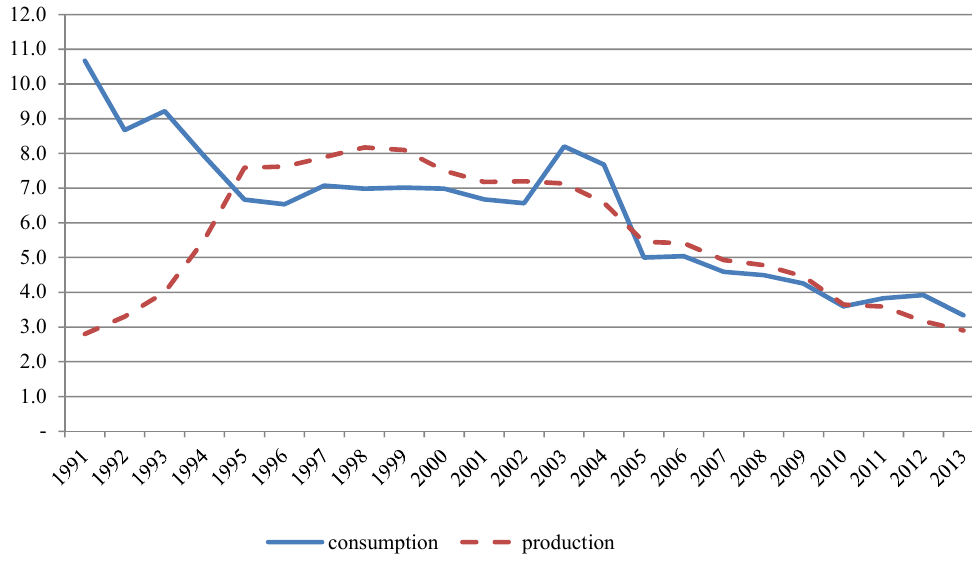
Fig. 2. Production and consumption of oil and gas condensate in Uzbekistan (million tons) Source: British Petroleum,